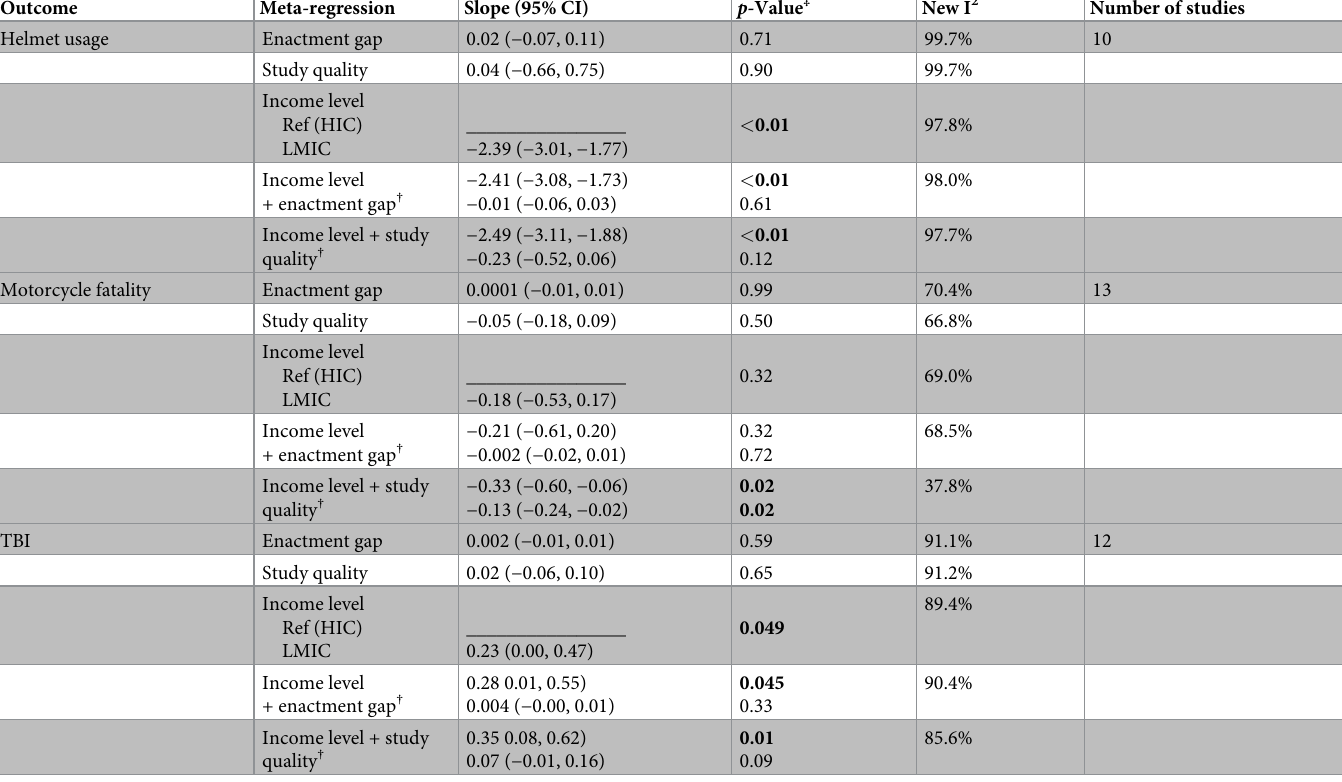
Table 2. Meta-regression analyses of each of the 3 outcomes on each of the following trial-level covariates: enactment gap (continuous); study quality (continuous); and income level (binary with ref = HIC).